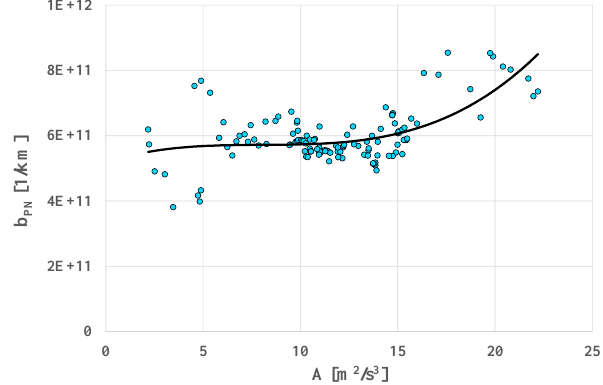
Fig. 22. Dependence of the average specific distance particle number on the average value of the absolute value of the product of vehicle velocity and acceleration in the Malta